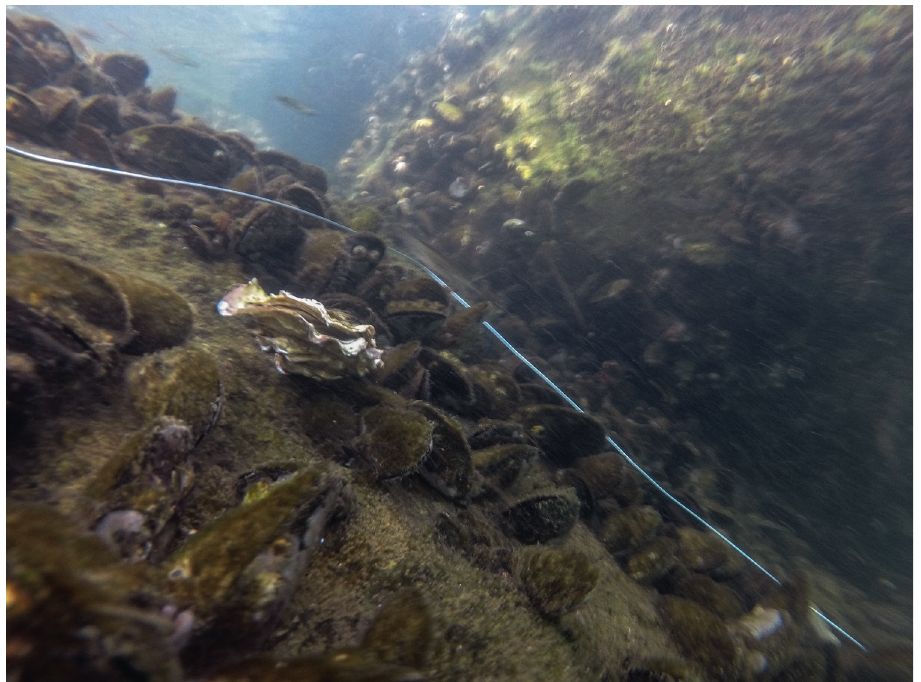
Figure 2 . Magallana gigas habitat from the Romanian Black Sea